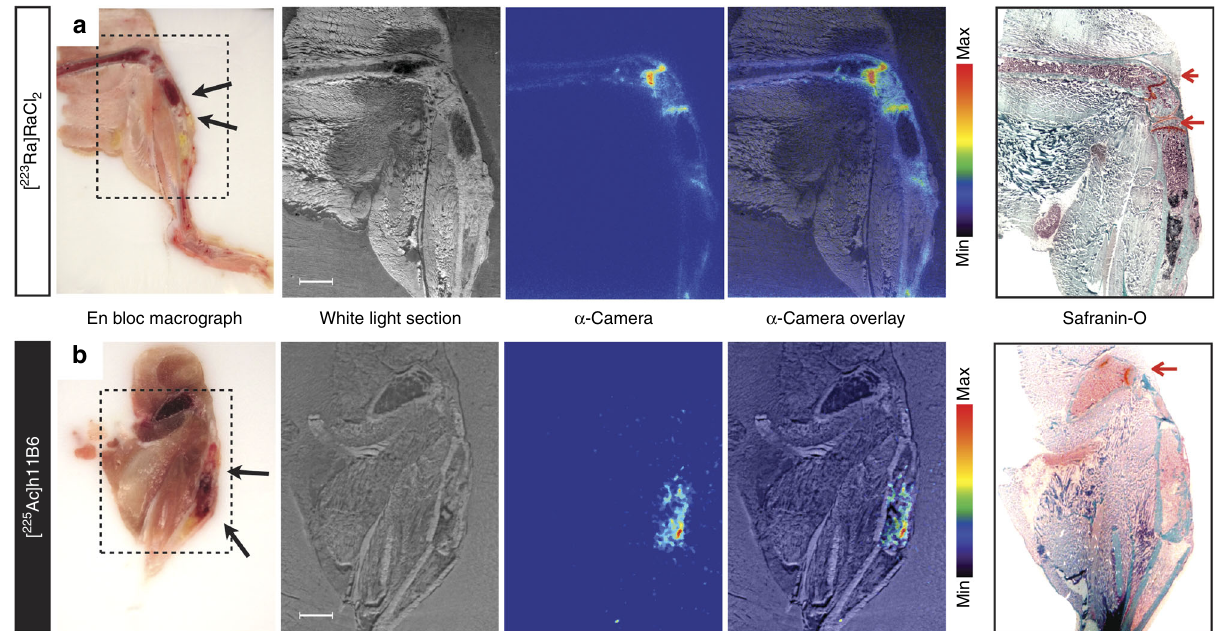
Fig. 2 Comparative microdistribution of [ 223 Ra]Cl 2 and [ 225 Ac]hu11B6 in mice bearing intratibial LNCaP-AR disease showed a differential uptake in vivo. Autoradiograms of ( a ) [ 223 Ra]Cl 2 and ( b ) [ 225 Ac]hu11B6 demonstrated distinctly different microdistributions of activity. While [ 225 Ac]hu11B6 localized directly to the tumor (indicated by black arrows in macrographs), [ 223 Ra]Cl 2 showed accumulation in apposite bone surface surrounding the lesion, as well active sites of both bone modeling and remodeling (n.b., disease is comprised of both osteolytic and osteoblastic bone lesions). Sequential tissue sections developed using Safranin-O, which differentiates mineral bone (green colored staining effect) from proteoglycans and cartilage (red-orange colored staining effect). The mineralizing front behind the growth plate at the epiphyses (red arrow) as shown in the Safranin-O stain show intense 223 Ra uptake (Fig. 2a); antibody-targeted 225 Ac does not accumulate at these sites (Fig.